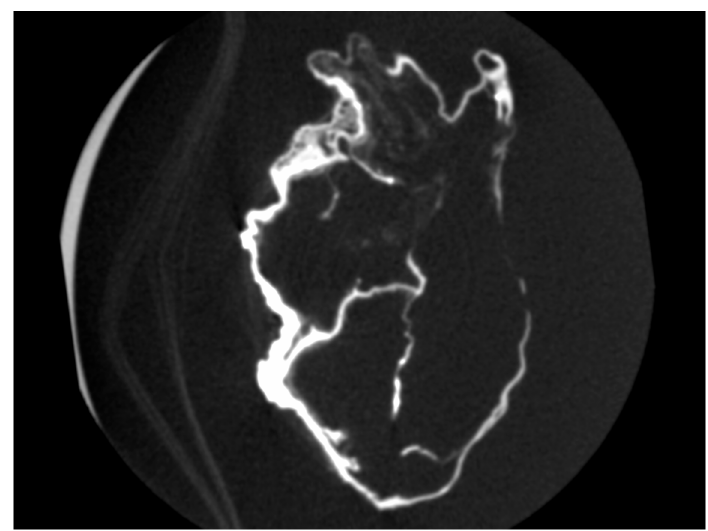
Figure 4. Four cavities of the heart of P. Jaricot .